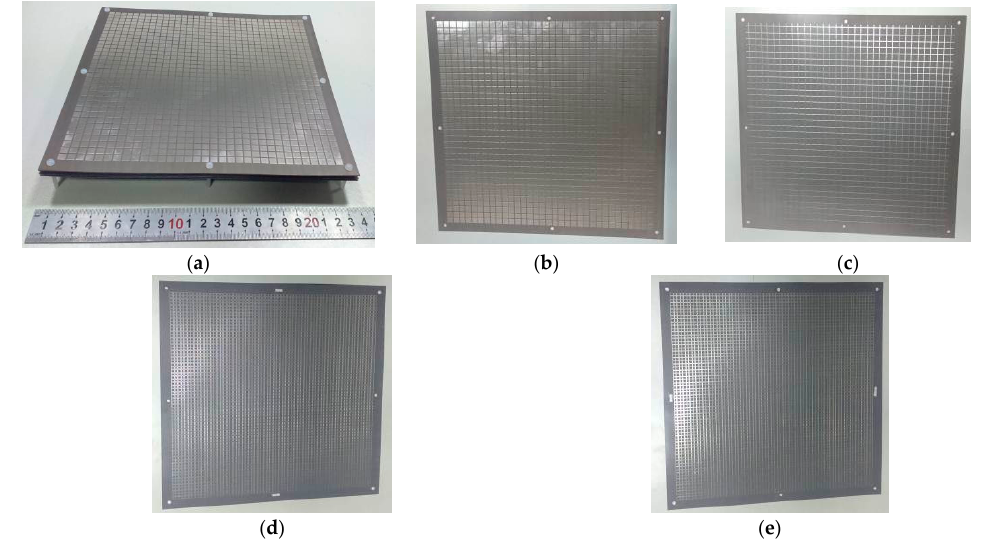
Figure 12. Geometry of the fabricated multilayer patch-grid FSS integrating with HS-FSMSE, ( a ) total view, ( b ) patch layer, ( c ) grid structure layer, ( d , e ) harmonic suppression FSMSE layers.